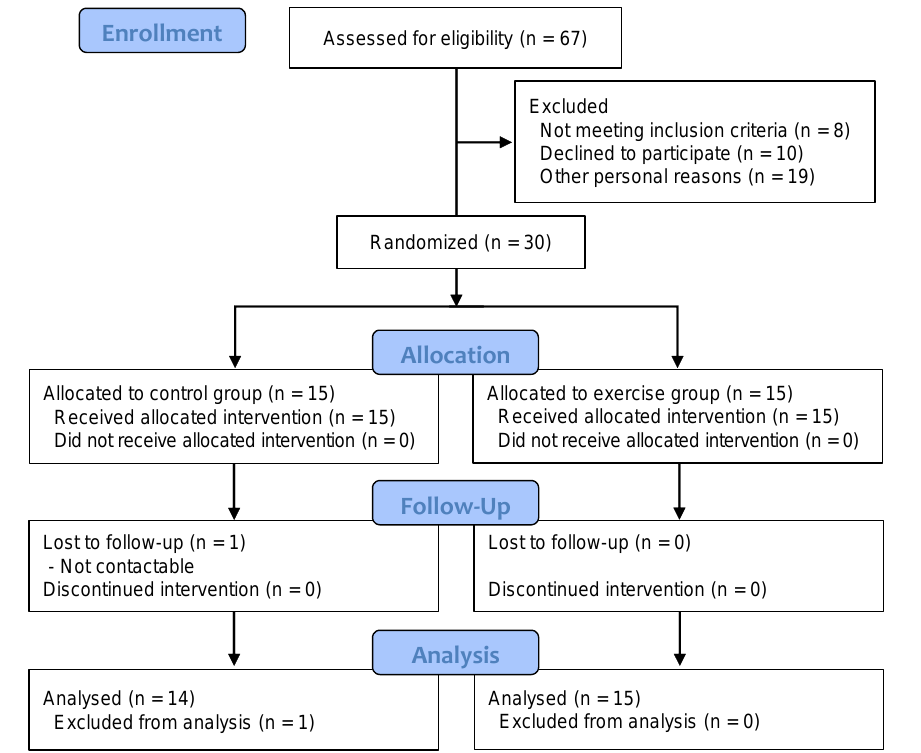
Figure 2. CONSORT flow chart of the exercise intervention study. Table 1. Changes in kinanthropometric parameters from baseline to 12 weeks.